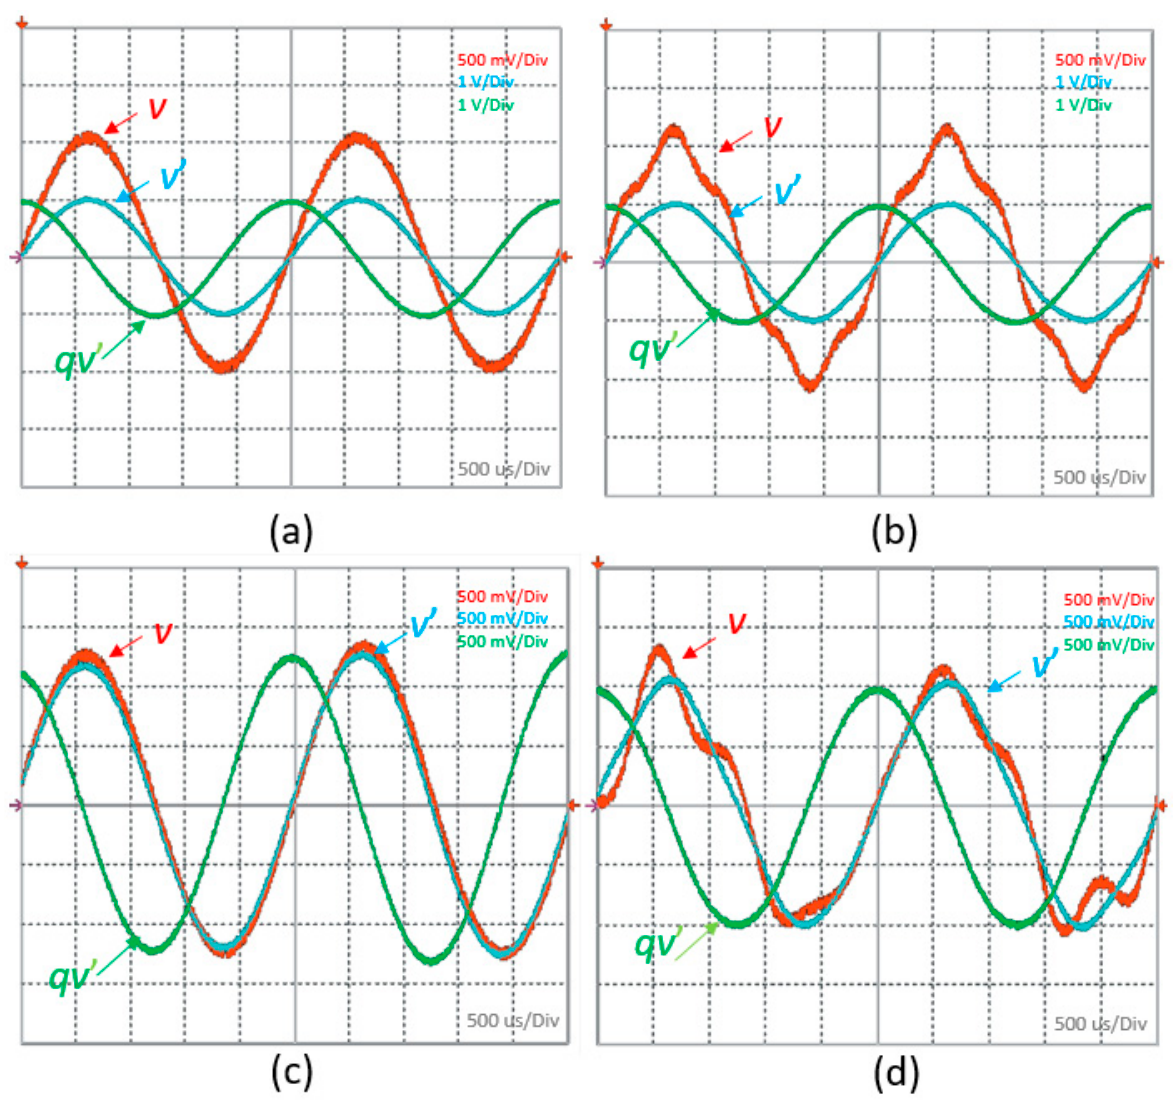
Figure 9. Steady-state responses of the FLC synchronizers: ( a ) waveforms of the input signal ( v ), estimated sine signal ( v ’), estimated cosine signal ( qv ’) under sinusoidal condition; ( b ) waveforms of the input signal ( v ), estimated sine signal ( v ’), estimated cosine signal ( qv ’) with 5-th harmonic distortion; ( c ) waveforms of the input signal ( v ), estimated sine signal ( v ’), estimated cosine signal ( qv ’) with subharmonics distortion; ( d ) waveforms of the input signal ( v ), estimated sine signal ( v ’), estimated cosine signal ( qv ’) with interharmonics distortion.